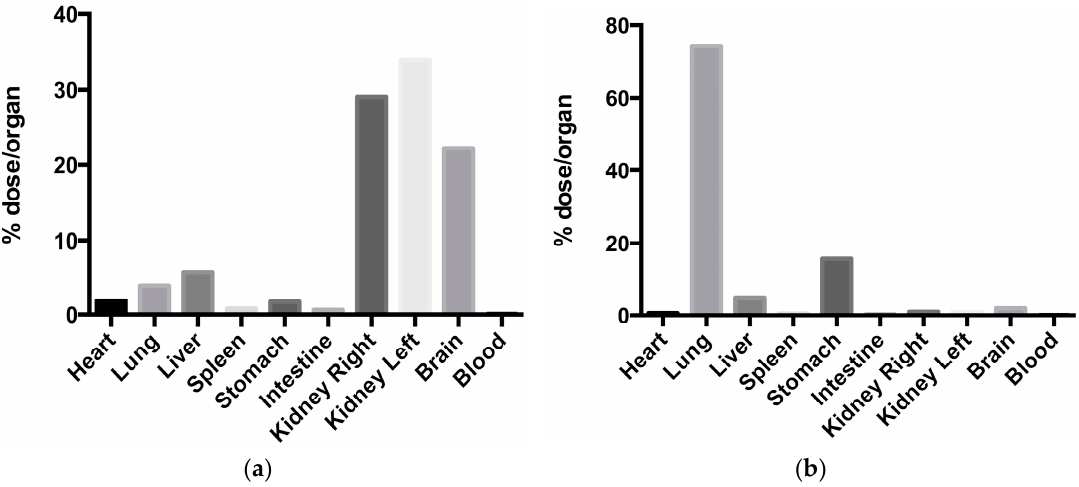
Figure 4. Fraction of total radioactivity recovered per organ 90 min after nasal administration to rats of ( a ) 99m Tc-labelled simvastatin-loaded nanoparticles; ( b ) 99m Tc-labelled simvastatin suspension [113] .